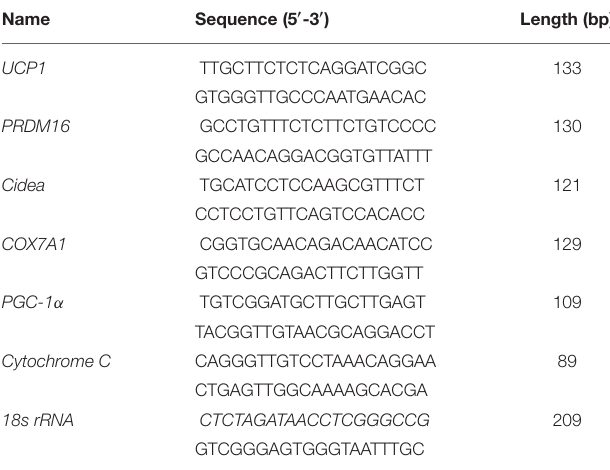
TABLE 1 | Primer sequences for real-time